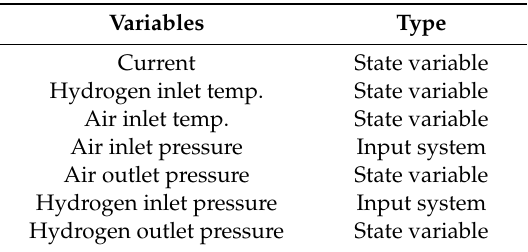
Table 3. Selected variables from PCA